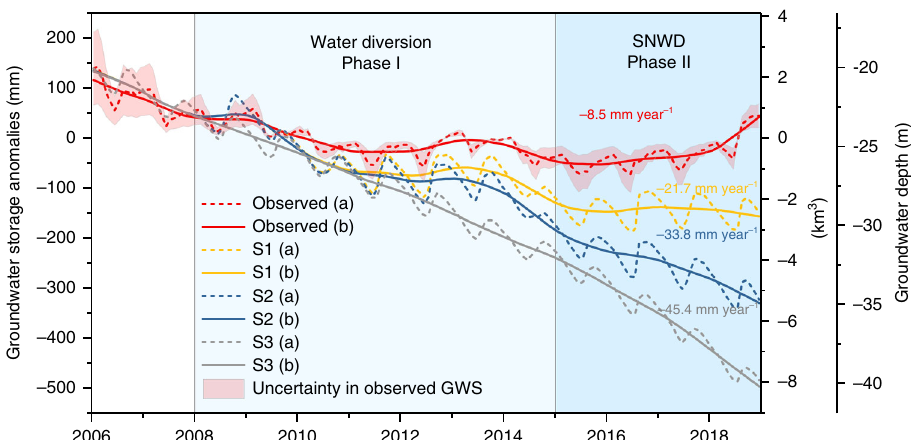
Fig. 5 Impact of factors on GWS recovery in Beijing for 2006 ‒ 2018. GWS anomalies and decomposed time series using the STL (Seasonal and Trend decomposition using Loess) decomposition method from in situ measurements and GWS simulations from the CWatM-MODFLOW model during 2006 ‒ 2018 under three scenarios (S1 ‒ S3). Shown also are linear GWD changing rates for each decomposed time series, with the signi fi cance of these rates listed at the 0.05 level (referring to the “ Methods ”